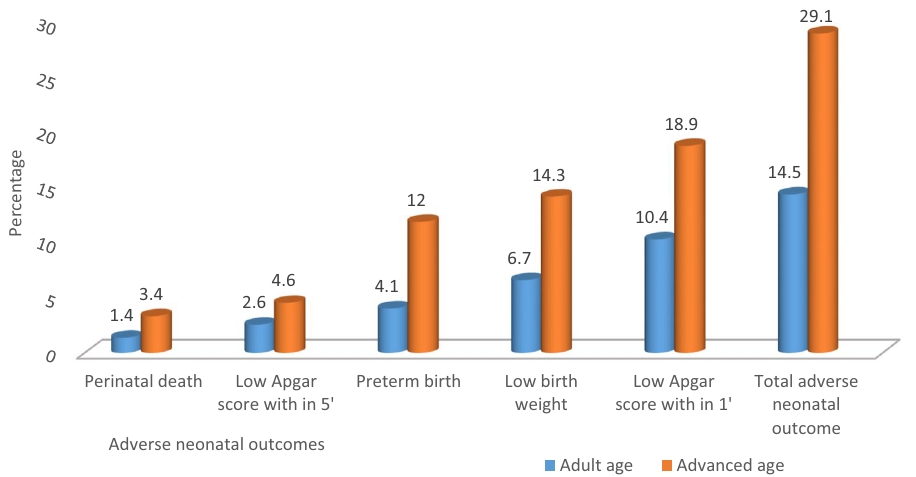
Figure 2. Adverse perinatal outcomes among adult and advanced age mothers who gave birth at Awi zone public hospitals, Ethiopia,